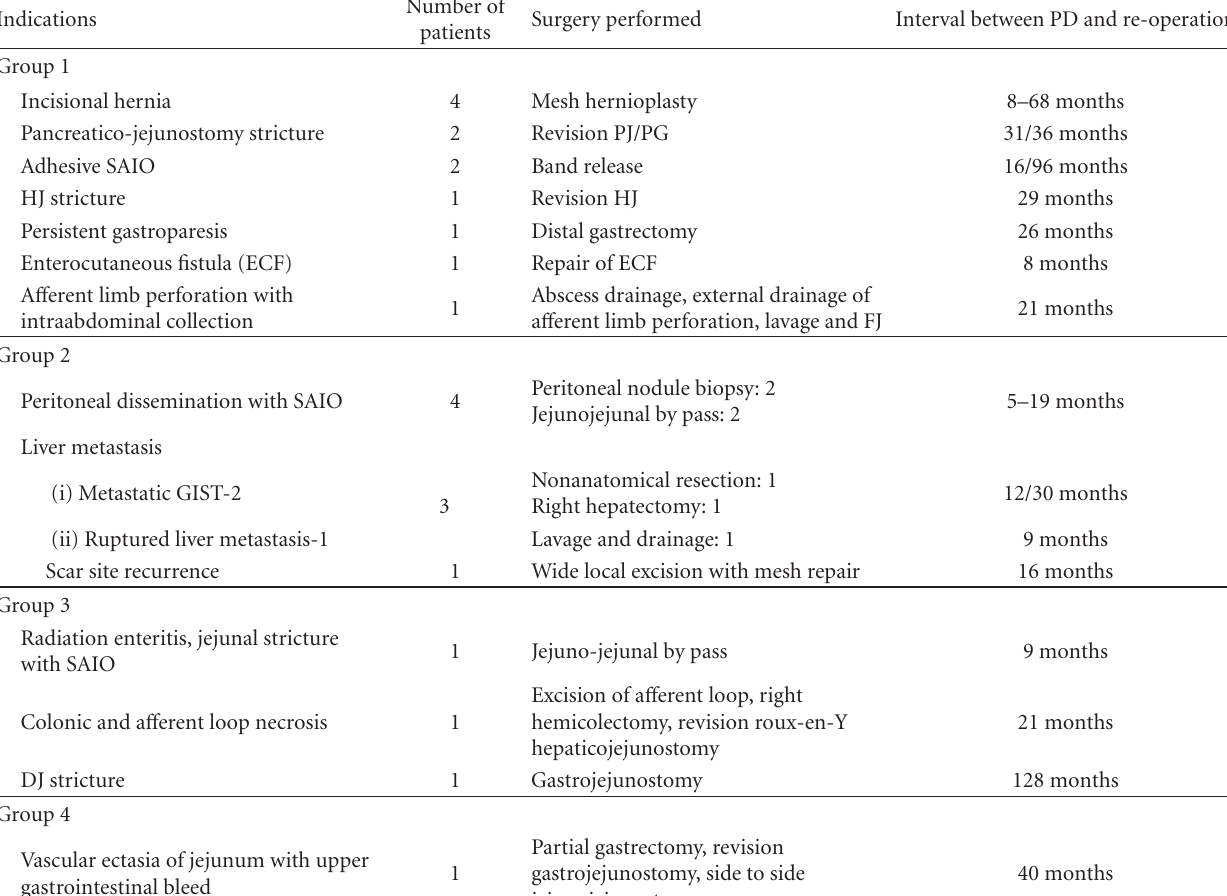
Table 4: Indications for late